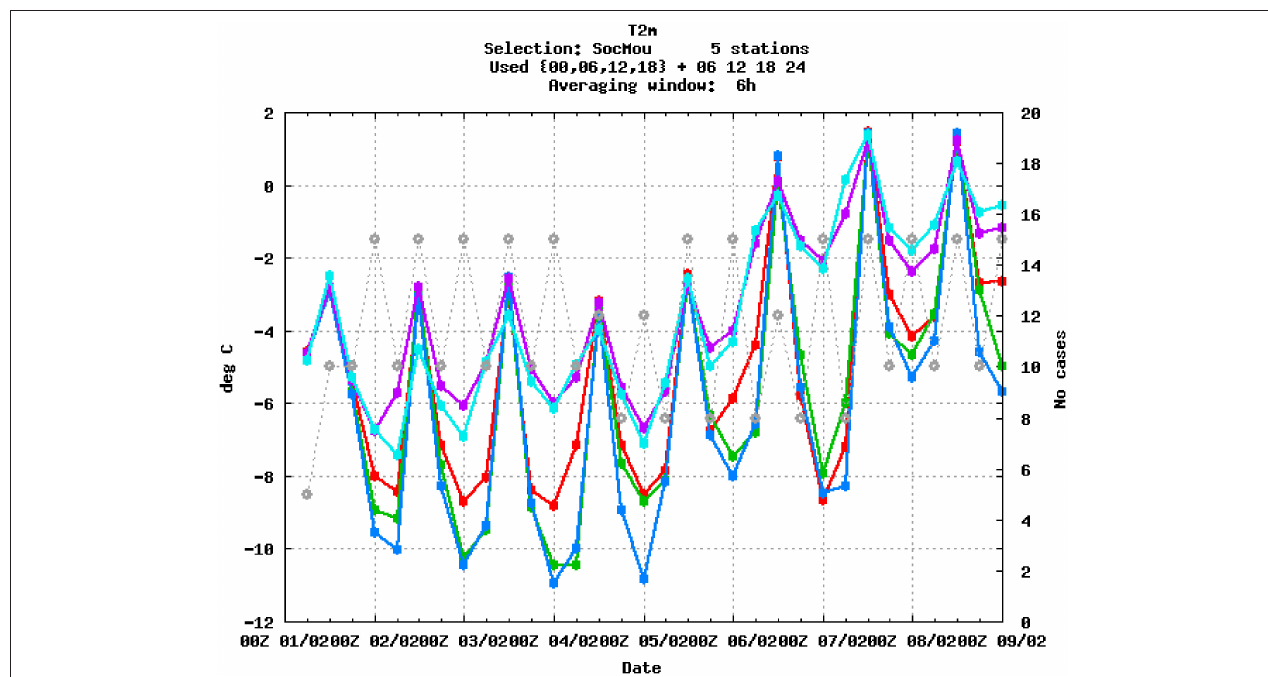
FIGURE 6 | Comparison of screen-level temperatures over the Olympic mountain cluster stations during the first week of February 2014: observed (light blue), the reference Olympic experiments with 2500m (red), 1500m (green), 1000m (dark blue) resolution and 1500m without surface sublayer scheme (violet). Number of cases (model-observation pairs) used for validation are shown with gray